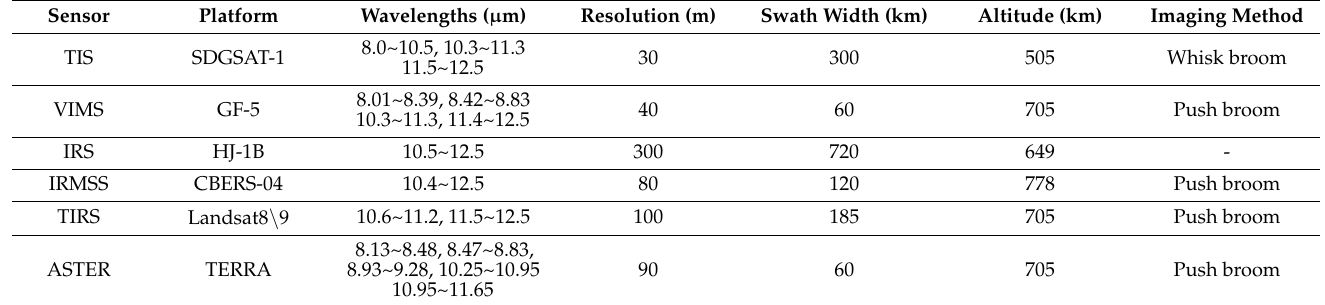
Table 1. SDGSAT-1 TIS characteristics and the comparison of other TIR